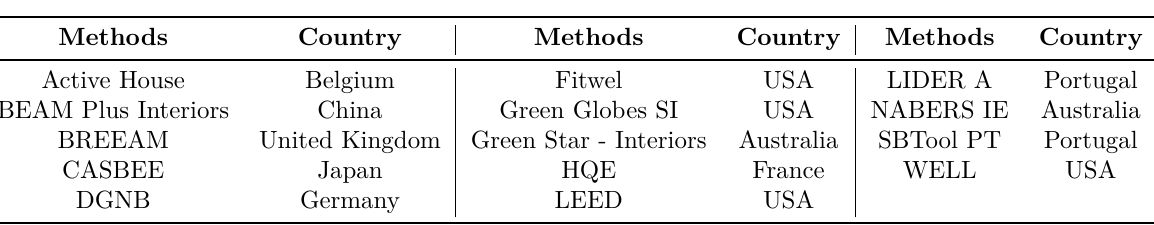
Table 1. Methods analysed and their